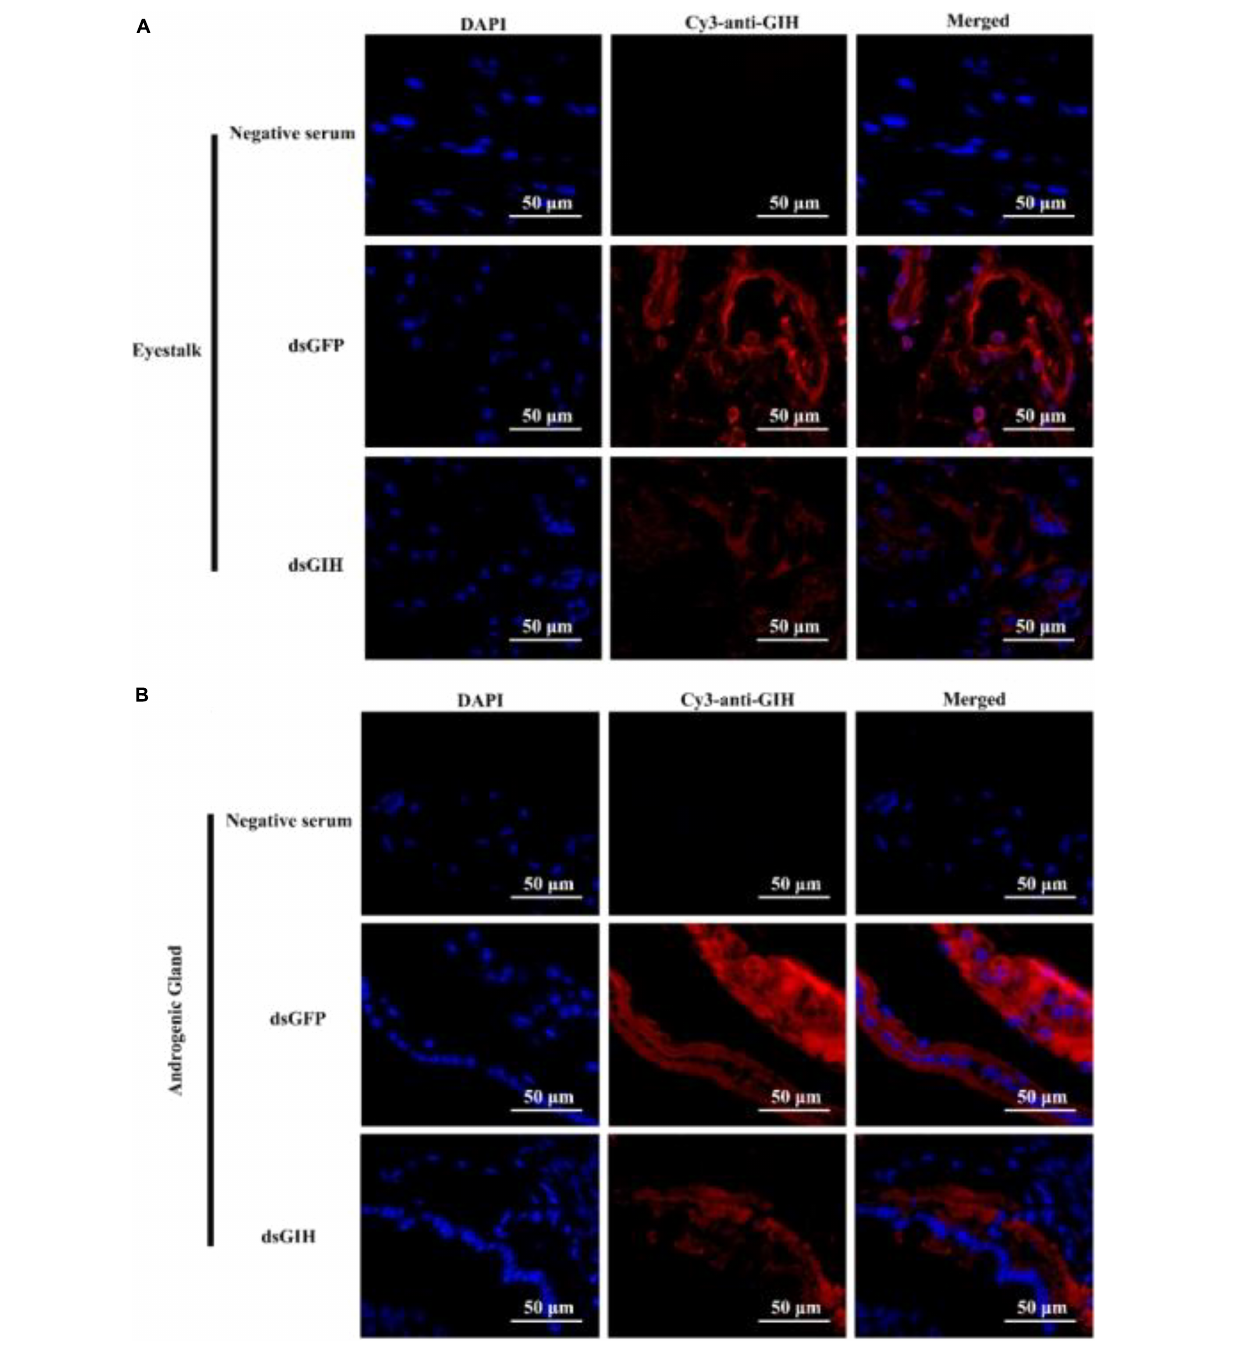
FIGURE 6 | The protein expression levels of Mr GIH after gene silencing using immunohistochemistry. ds GFP, injected with ds GFP RNA; ds GIH, injected with ds GIH RNA. Mr GIH was in red fluorescence signals. The protein expression levels of Mr GIH in the eyestalk (A) and androgenic gland (B) after injected with dsMr GIH at 24 h. Negative serum served was as the control. Scale bar was indicated 50 µ